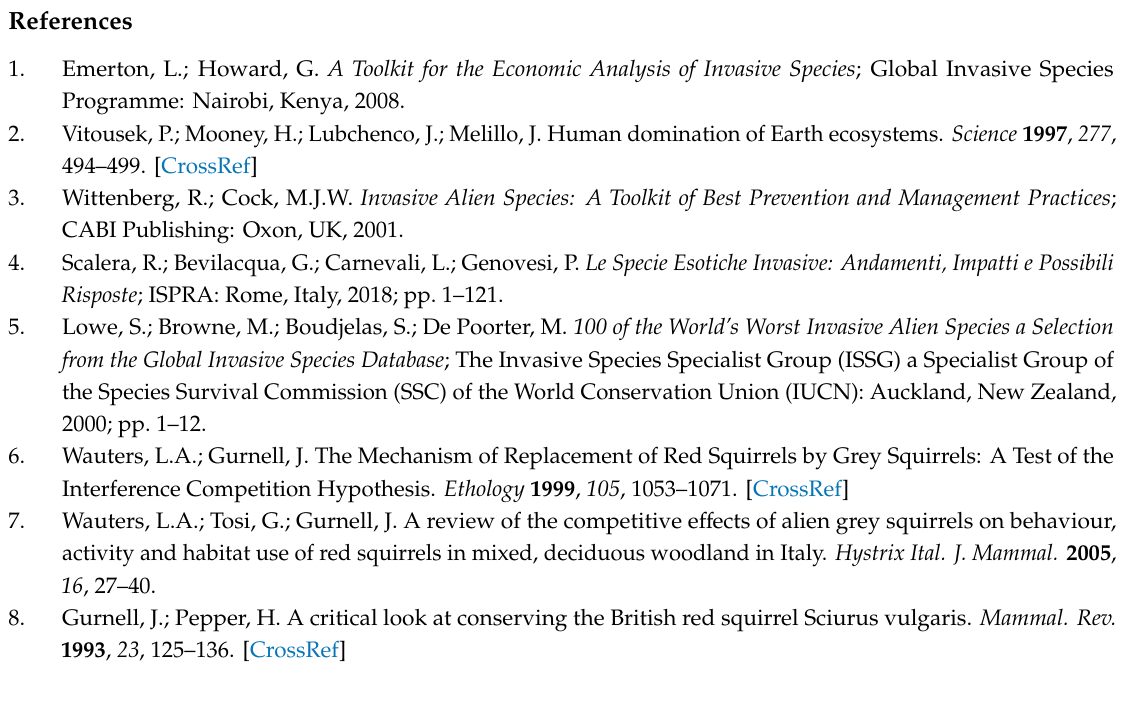
Table S1: Demographic characteristics of wild gray squirrels undergoing gonadectomy during pilot study 1 and 2; Table S2: Parameters related to the quality of sedation, surgical techniques, and recovery phase for wild gray squirrels undergoing gonadectomy during pilot study 1 and 2; Table S3: E ff ect of the season on the basal physiologic parameters of wild gray squirrels undergoing